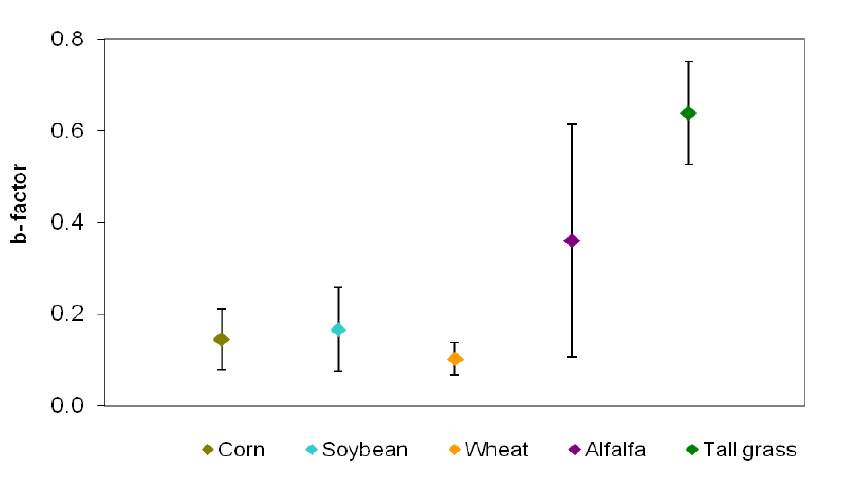
Figure 3. Averaged b- factor and the range for different vegetation